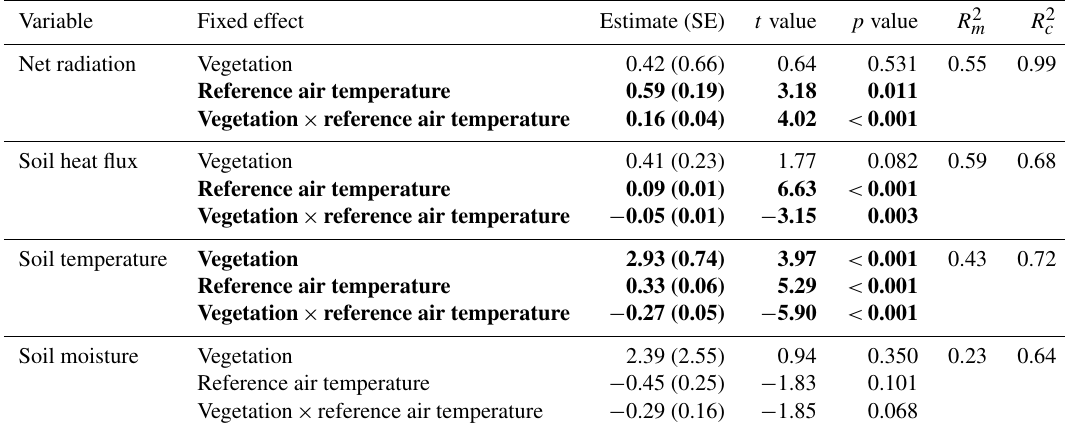
Table C1. Results of the linear mixed models for the effect of vegetation type and air temperature on the daytime total net radiation, the daytime total soil heat flux, the daytime average soil temperature and the daytime average soil moisture. Statistically significant effects ( p< 0 . 05) are indicated in bold. R 2 m indicates the variation explained by the fixed effects, and R 2 c indicates the variation explained by the entire model. See Fig. 7 for a visualization of the models.